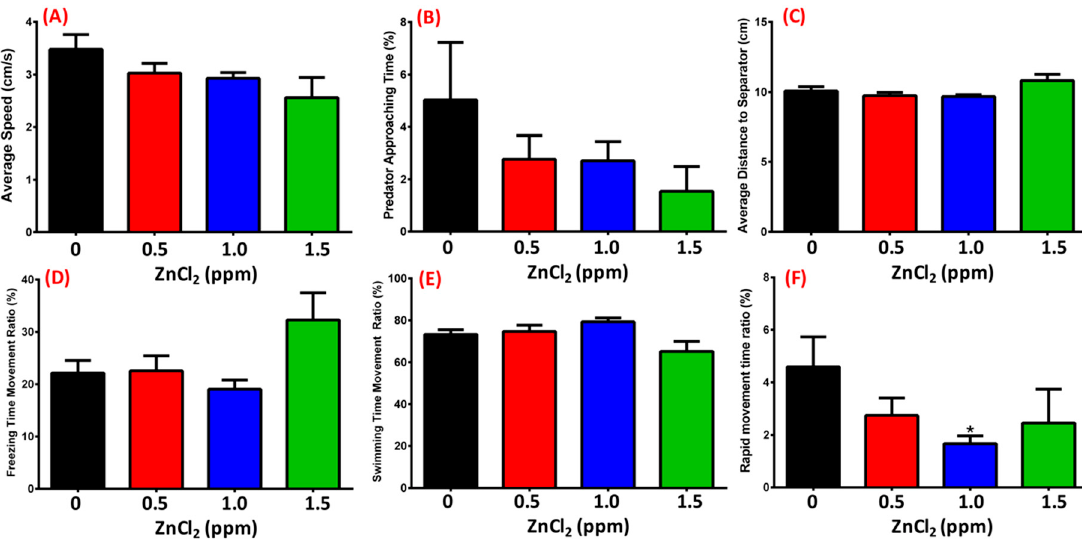
Figure 5. Predator avoidance test after 13-day exposure. ( A ) Average speed; ( B ) predator approaching time; ( C ) average distance of zebrafish to separator; ( D ) freezing movement time ratio; ( E ) swimming time movement ratio; ( F ) rapid movement time ratio of zebrafish. Statistical analysis was performed using a non-parametric Mann–Whitney test (* p ≤ 0.05). Sample sizes were 32, 14, 16, and 7 fish for the control, 0.5 ppm, 1.0 ppm, and 1.5 ppm ZnCl 2 -exposed groups, respectively.